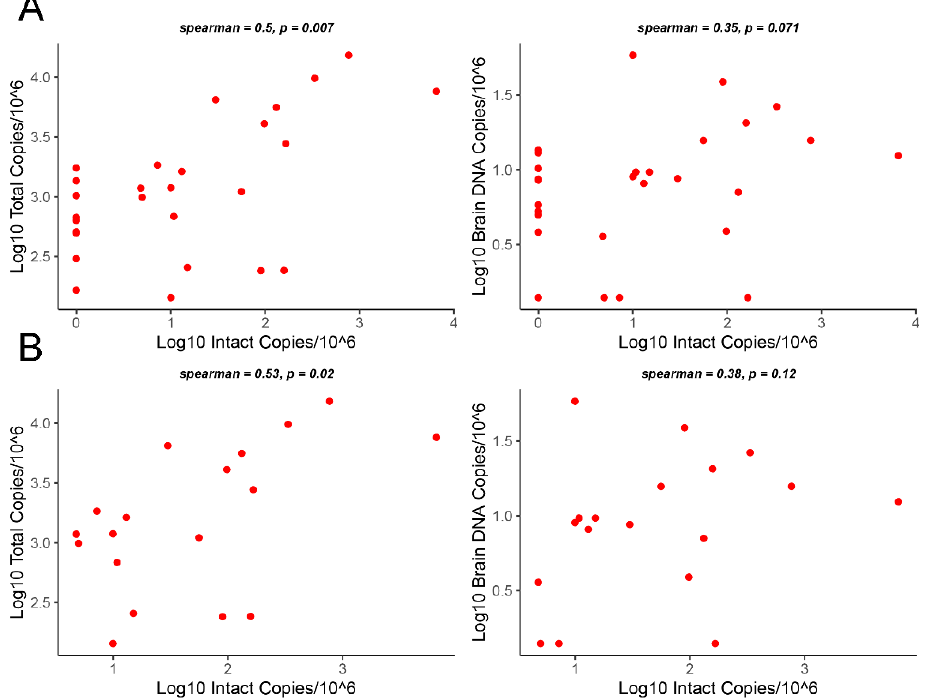
Figure 2. Correlation analysis of intact versus total HIV provirus or gag DNA levels in brain tissue from HIV+ individuals on ART. ( A ) Correlation between log10 intact provirus copy number and log10 total provirus copy number or log10 gag DNA copy number (standardized to 10 6 cells) in brain tissue (frontal lobe white matter) among 28 HIV+ individuals. ( B ) Correlation analysis as described in sensitivity analysis ( A ) restricted to 18 HIV+ individuals with detectable intact proviruses (>1 intact copy per 10 6 cells). Spearman ’ s rho and p -values are shown.